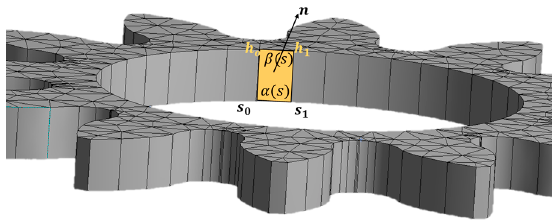
Figure 7. Representation of the differential boundary elements used for deriving the leakages.